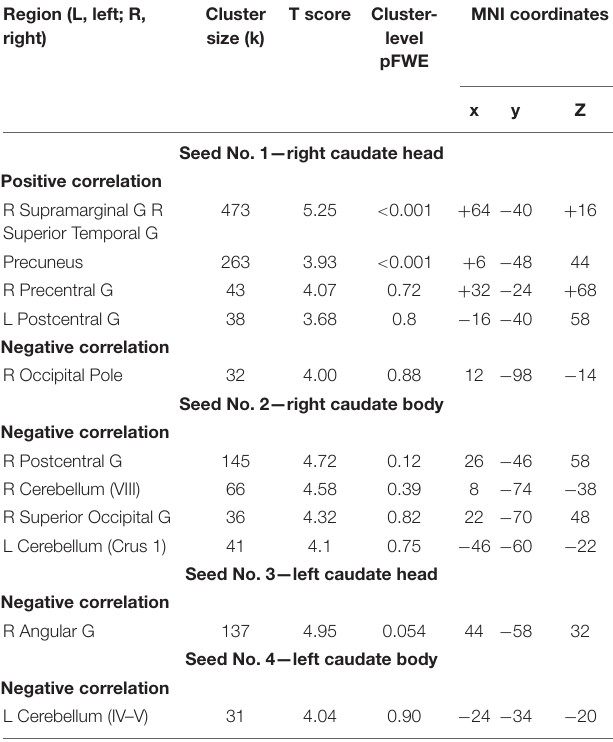
TABLE 1 | Results of the seed-based analysis and multiple regression with the z-transformed sum of raw scores included as a covariate of interest (threshold, voxel-level uncorrected p < 0.001, minimal cluster size (k)—30). Region (L, left; R,